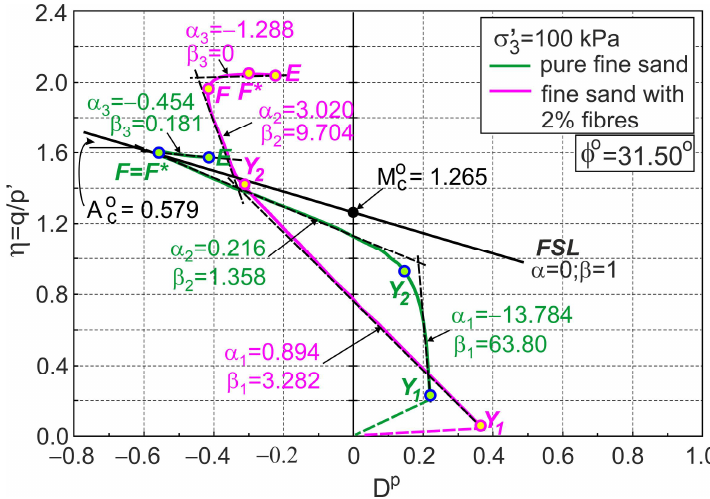
Figure 1. Characteristic stages of shearing of pure and fibre-reinforced fine sand (based on the experimental data from [5]).